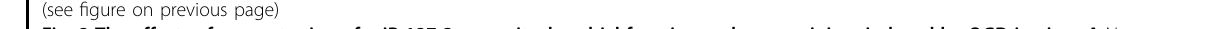
Fig. 2 The effects of sequestration of miR-127-3p on mitochondrial function and neuron injury induced by OGD in vitro. A Neurons were stained by Tuj1, reactive oxygen species (ROS), Mito tracker and TUNEL to detect the condition of neurons, the level of ROS, the condition of mitochondria and neurons apoptosis in normal group, OGD group, mimic-NC group, anti-NC group, miR-127-3-p group, and anti-miR-127-3p group. Scale bar = 100 μ m (Mito tracker: scale bar = 50 μ m). B The bar charts of neurons viability in neurons of each group. Compared with normal group, the neurons viability decreased in OGD group, there was statistic signi fi cant. While the neurons viability increased in anti-miR-127-3p group, compared with OGD group. C The level of ROS in neurons of each group. ROS signi fi cantly increased in OGD group, compared with normal group. Whereas, ROS were signi fi cantly decreased in anti-miR-127-3p group compared with OGD group. D The mitochondria mean fl uorescence in neurons of each group. Mito mean fl uorescence signi fi cantly decreased in OGD group. Whereas mito mean fl uorescence signi fi cantly increased in anti-miR-127-3p group, compared with OGD group. E Percentage of TUNEL/DAPI of neurons was shown in each group. TUNEL staining was used to analyze neuronal apoptosis. The percentage of TUNEL/DAPI signi fi cantly increased in OGD group, compared with normal group. Whereas the percentage of TUNEL/ DAPI signi fi cantly decreased in anti-miR-127-3p group, compared with OGD group. The data were presented as the means± s.d. ** P < 0.01 with one- way ANOVA or Kruskal – Wallis, n = 6. OGD oxygen glucose deprivation, NC negative control, HI hypoxic ischemic, Mir microRNA, TUNEL